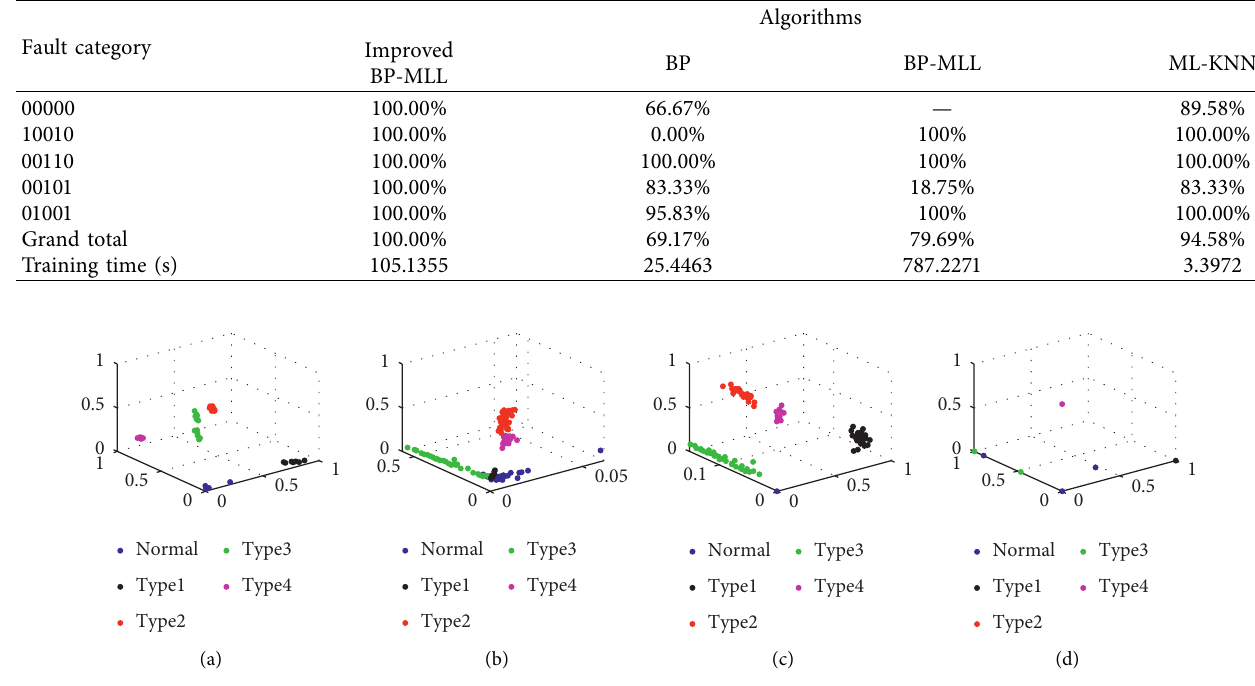
Figure 9: The classification results of different algorithms. Table 6: Performance comparison of different algorithms.